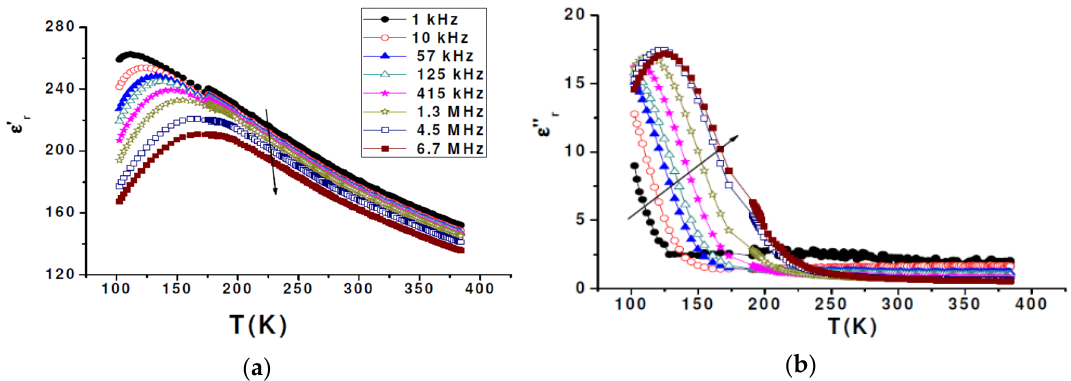
Figure 8. Real ( a ) and imaginary ( b ) parts of the c omplex dielectric permittivity, ε r ’ and ε r ’’, respectively, as a function of temperature and frequency for BCTZ1 (arrows indicate the direction of increasing frequency).